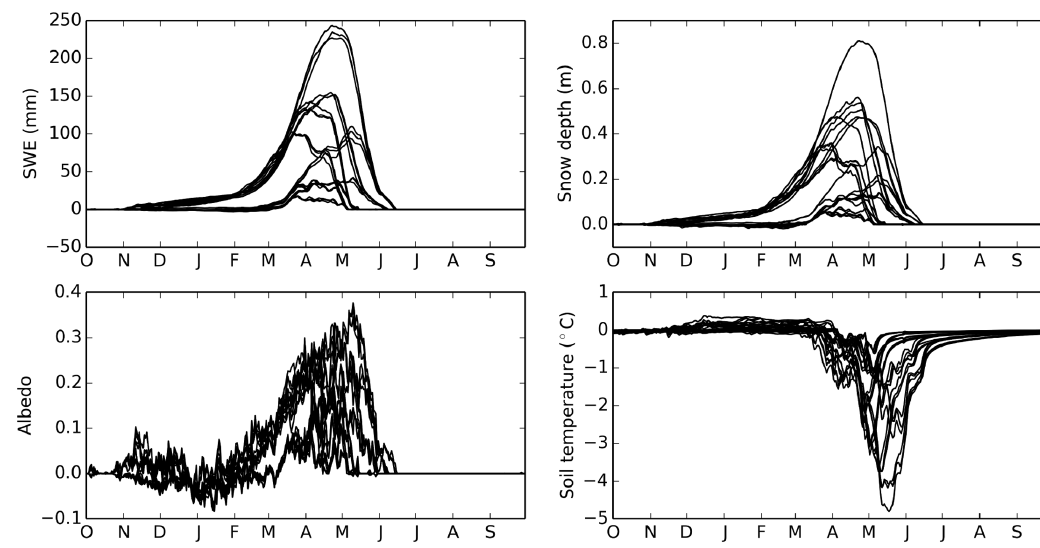
Figure 5. Differences between the 32 FSM ensemble members in fixed albedo and reference simulations for Col de Porte averaged over October 1994 to September 2014.